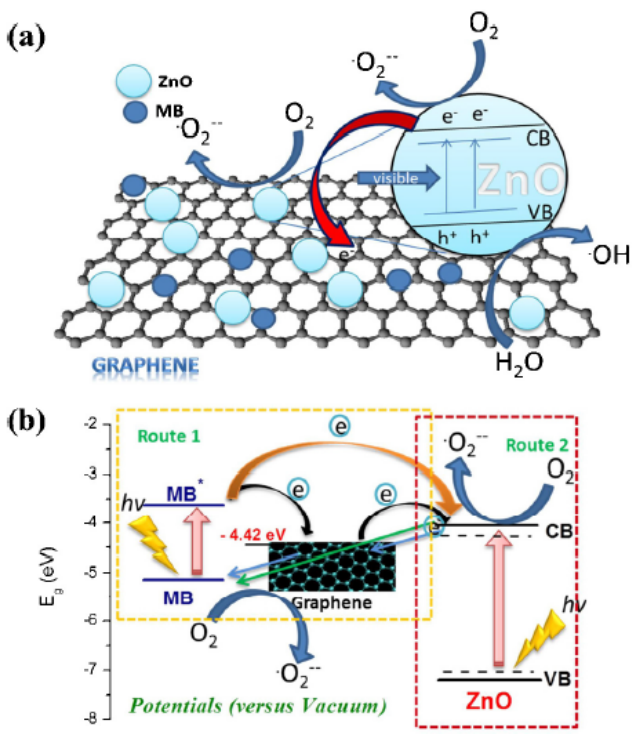
Figure 8. Two proposed mechanisms for the photodegradation of MB by rGO/ZnO composite under visible light and energy diagram of excited MB, graphene and the conduction band of ZnO. ( a ) The excitation of the semiconductor produced by light irradiation generates an electron-hole pair. The reaction with the organic pollutant takes place in the movement of those charges towards the particle surface. ( b ) The dye, which act as a light sensitizer, is excited and transfers electrons. It becomes a cationic radical that self-degrades. Reprinted with copyright permission from reference [131]. Copyright © 2013,